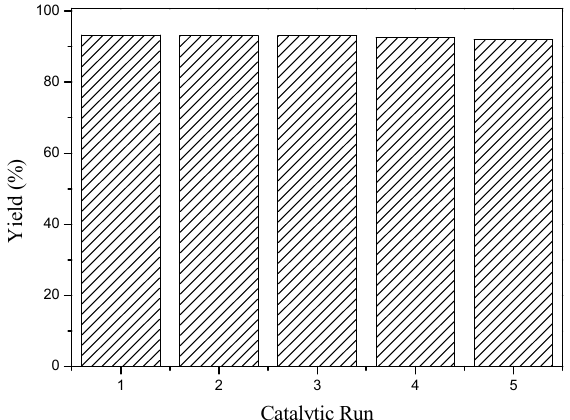
Figure 3. Reutilization of the Zn-NPClH catalyst. PO (10 mL, 0.143 mol), catalyst Zn-NPClH (1.43 mmol, 1 mol%), t = 3 h, T = 120 ◦ C, P = 1 MPa. The selectivity of PC was >99%.